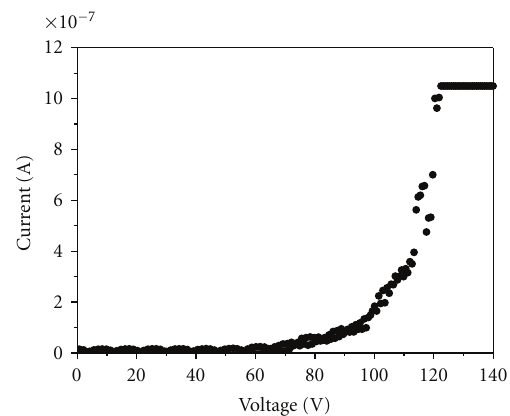
Figure 3: MWCNT field emission characteristics. The current reached 1 μ A at 120V, which was the maximum allowed current limit for safety